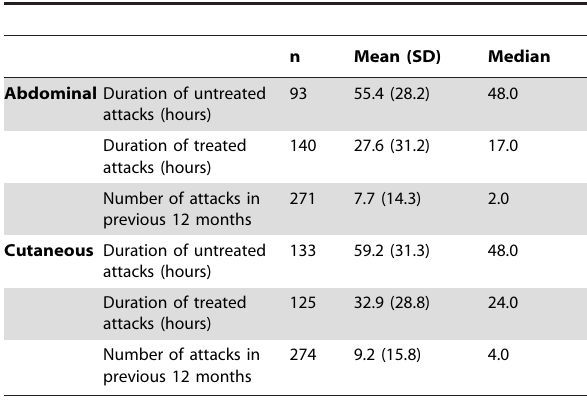
Table 3. Abdominal and cutaneous attack history from the previous 12 months for HAE type I and II patients.